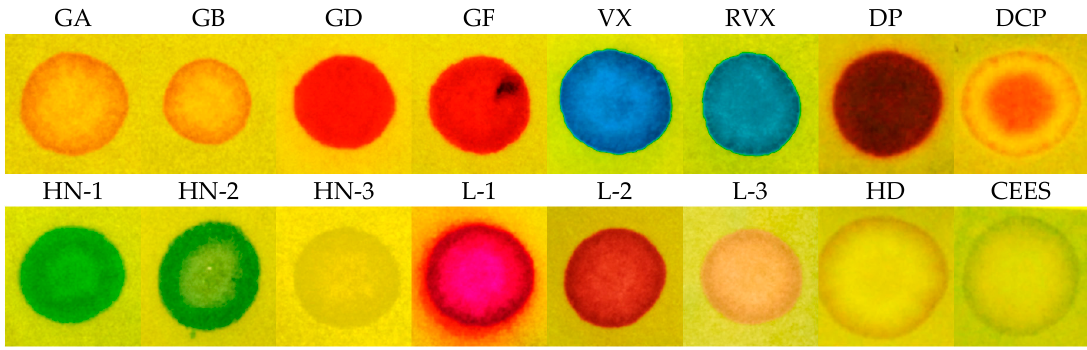
Figure 7. Response of the RM1a/PY-OPD/BCG detection paper to CWA. Table 1. The summary of tested CWAs, their physical and toxic properties and reactions with detection papers ( − no response, + distinct response, ++ strong response).